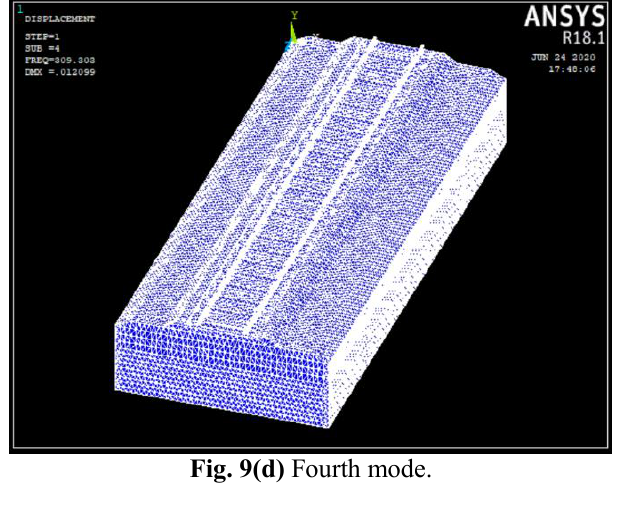
Fig. 9(d) Fourth mode.